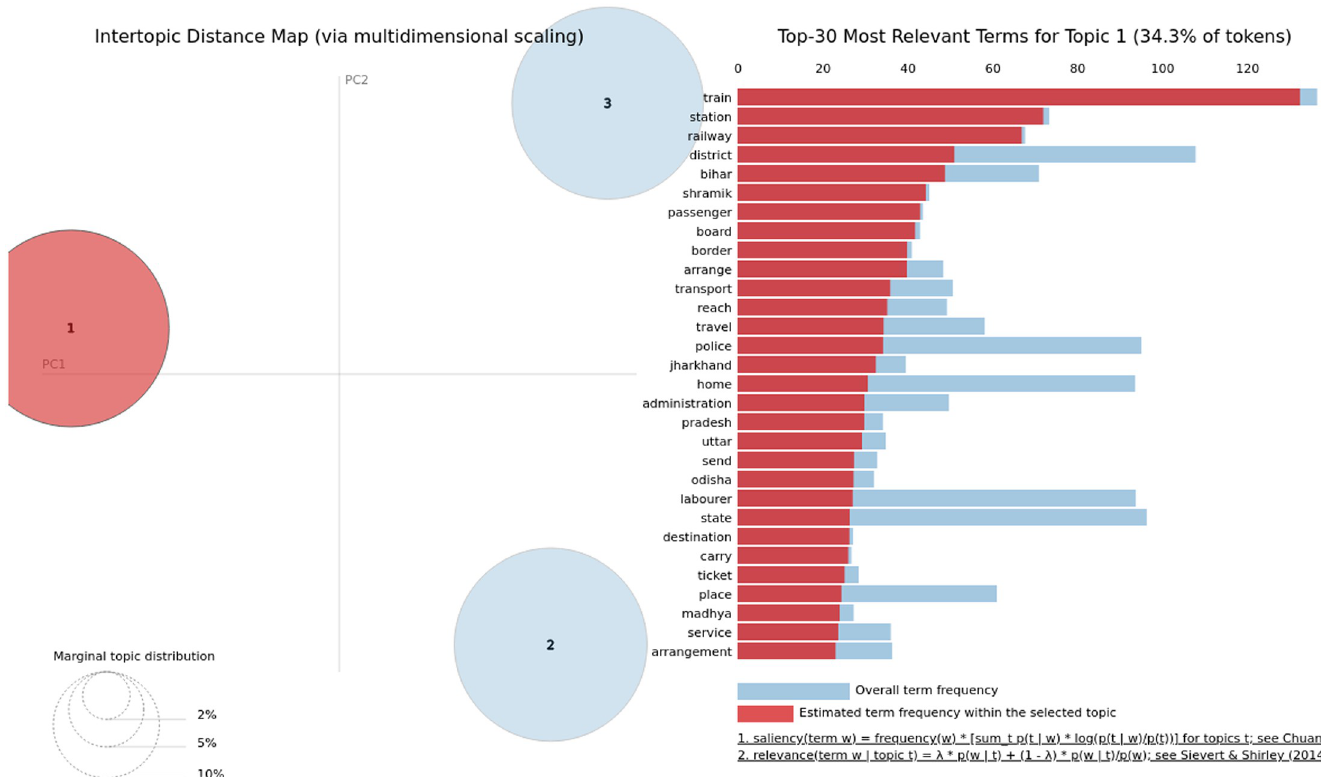
Fig 7. Illustrating the top 30 salient terms present in first topic identified using TF-IDF model employed on articles’ summaries. The bubble chart visualises the overlap in various topics plotted in a two dimensional (components) space.